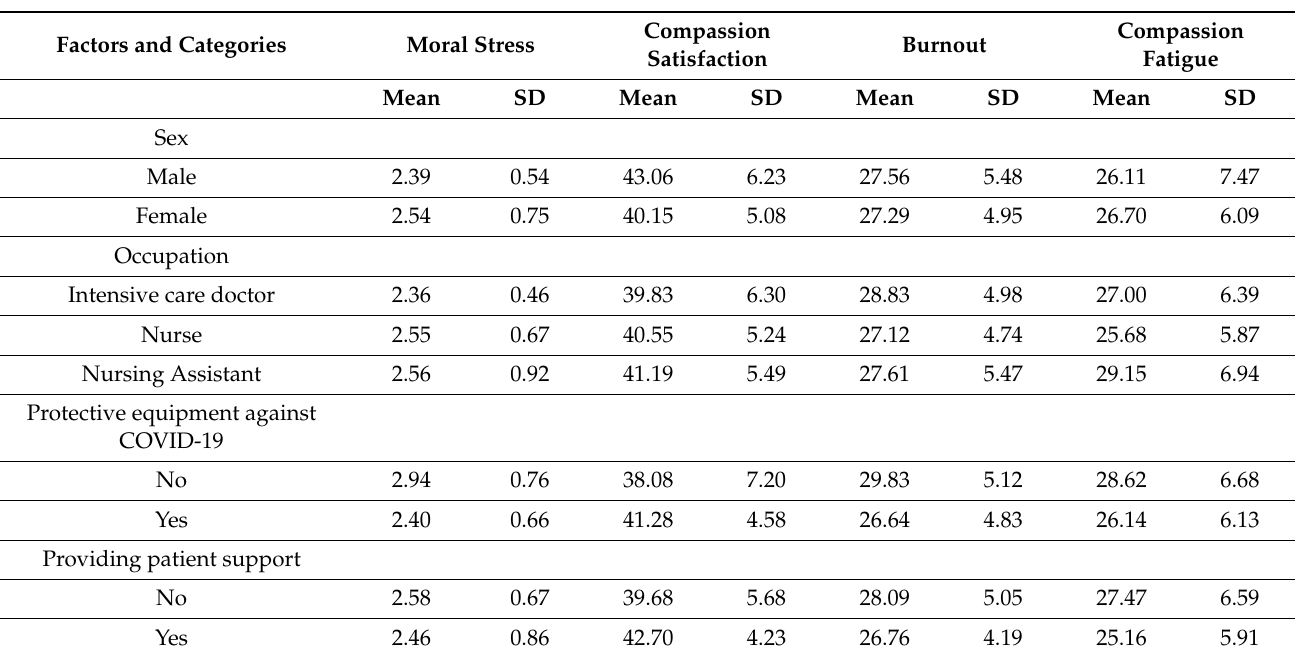
Table 4. Means and standard derivations for differences in professional quality of